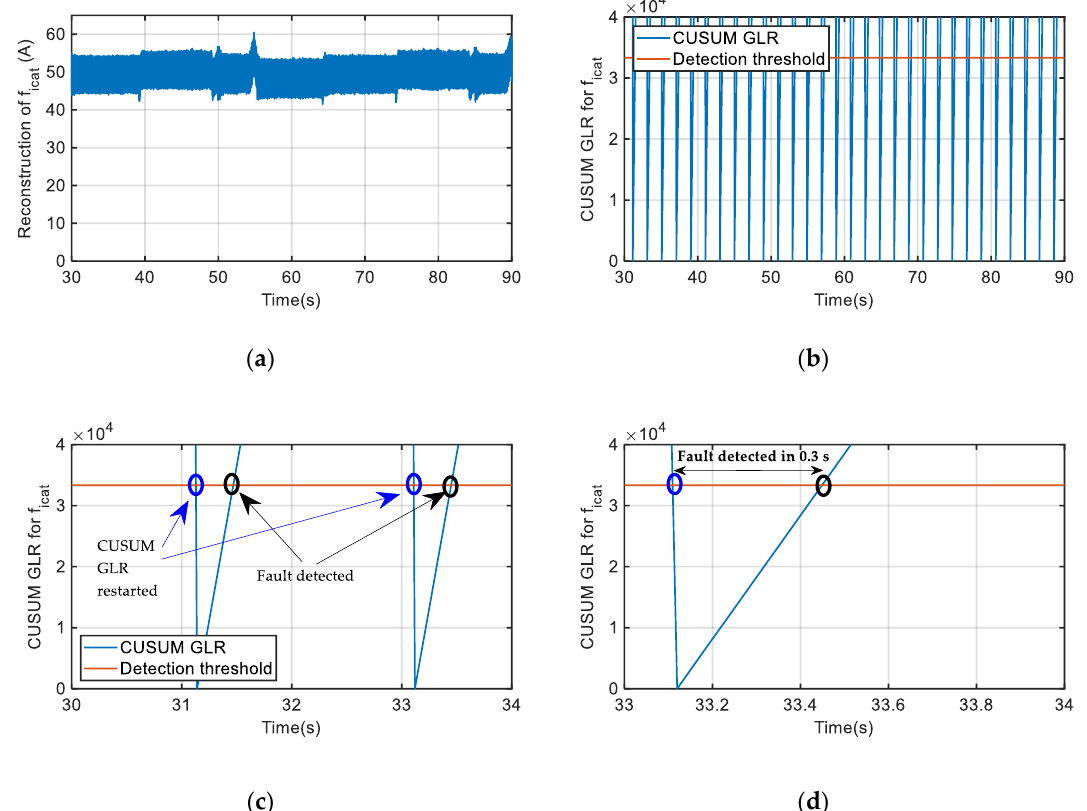
Figure 15. Offset fault injection in catenary current sensor. ( a ) Catenary current sensor fault reconstruction. ( b ) CUSUM GLR calculation. ( c ) Zoom of CUSUM GLR. ( d ) Time for fault detection.